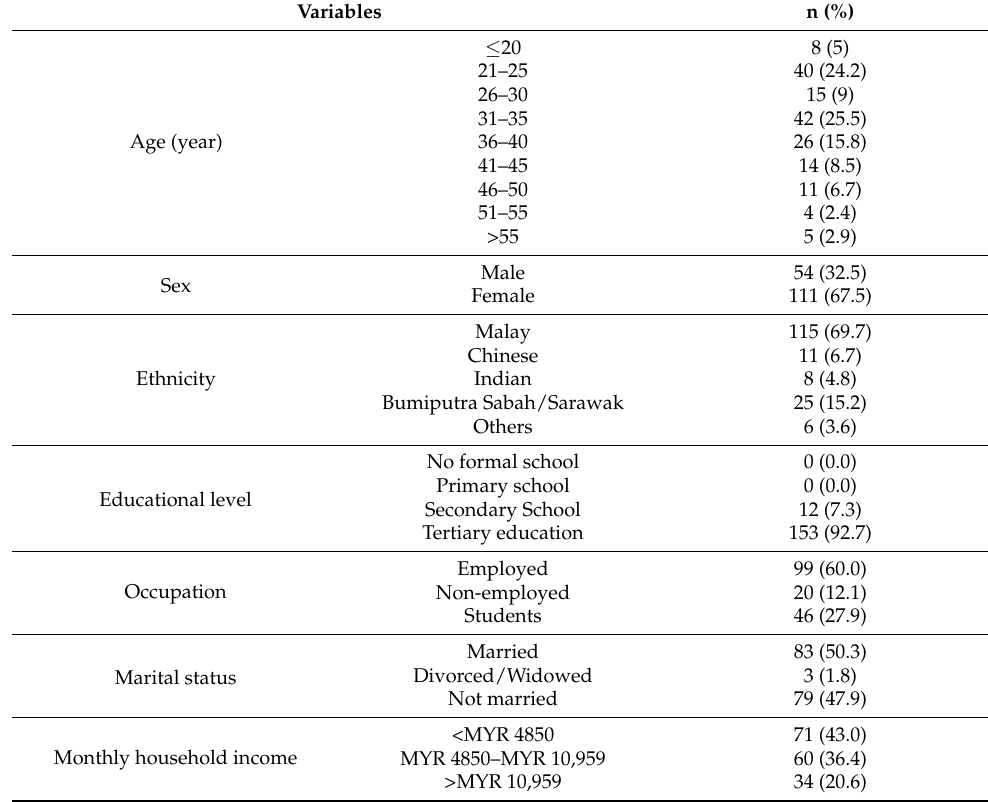
Table 1. Characteristics of the respondents (n = 165).